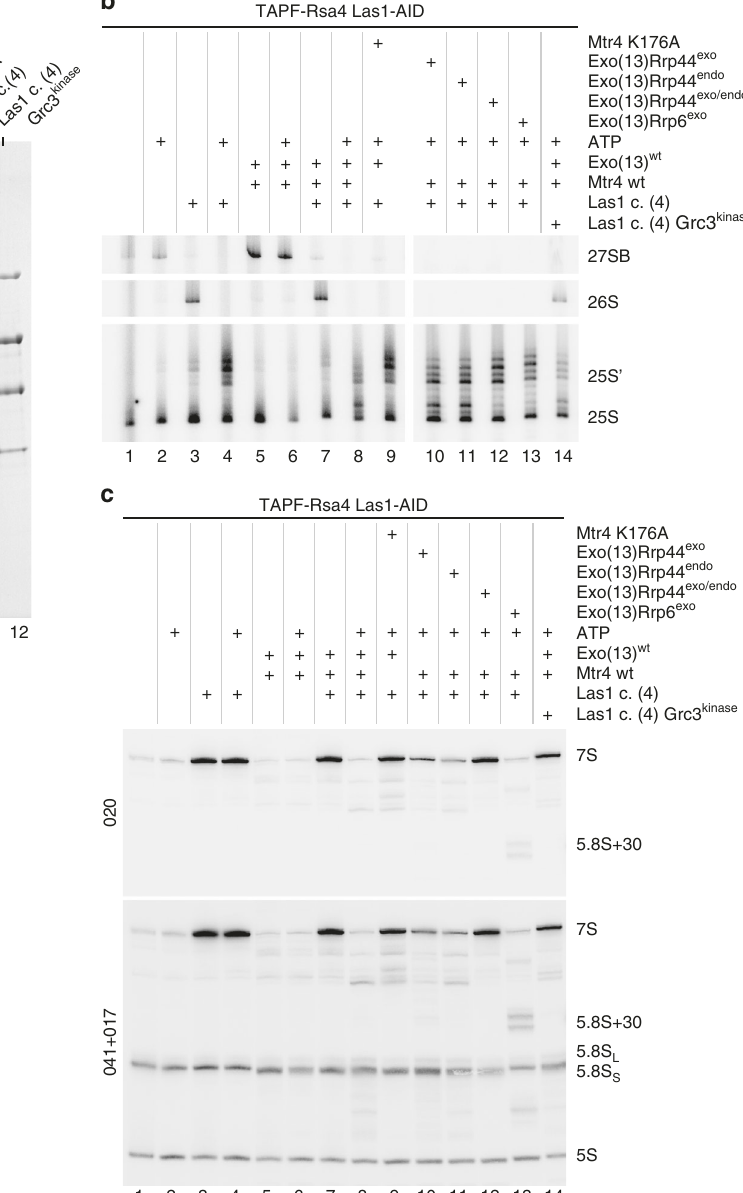
Fig. 5 Complete cycle of in vitro ITS2 processing by the combined activities of the Las1 complex and nuclear exosome. a Analysis of the protein samples used in the complete in vitro ITS2-processing assay. Substrate 27SB pre-rRNA was introduced by addition of pre-60S particles af fi nity-puri fi ed via TAPF- Rsa4 from a LAS1-AID degron strain. The yeast exosome subunits and Mtr4 were expressed in E. coli and af fi nity-puri fi ed from bacterial cell lysates. Exo(10) comprises the exosome core plus Rrp44. The Las1 complex (Rat1, Grc3, Las1, Rai1, from top to bottom) was overexpressed in yeast and TAP-puri fi ed via the split-tag approach (Las1-TpA/Grc3-Flag), yielding a wt and a mutant Las1 complex with a defective Grc3 kinase. The indicated eluates were analysed by SDS-PAGE and Coomassie staining. b Primer extension for detection of 27SB pre-rRNA, 26S pre-rRNA, 25S ’ pre-rRNA and 25S rRNA. c Northern blotting for detection of 7S pre-rRNA, 5.8S rRNA and 5S rRNA after the in vitro processing reaction. Processing of 27SB substrate pre-rRNA present in pre-60S particles (af fi nity-puri fi ed via TAPF-Rsa4 from LAS1-AID degron strain) using the recombinant exosome and its cofactor Mtr4, and af fi nity-puri fi ed Las1 complex, either wt or harbouring the Grc3 kinase mutant. The in vitro reactions contained the puri fi ed proteins and ATP as indicated. 7S pre-rRNA was detected with two different probes. 5S rRNA served as a loading